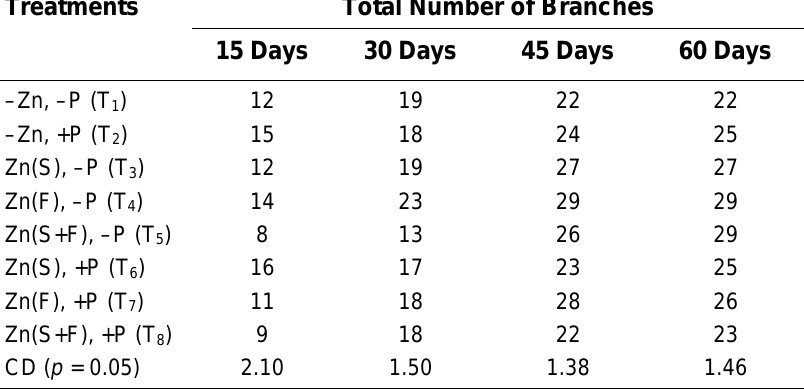
Interaction Effect Between Zn and P on the Total Number of Branches of Stevia ( S. rebaudiana ) (Mean of Four